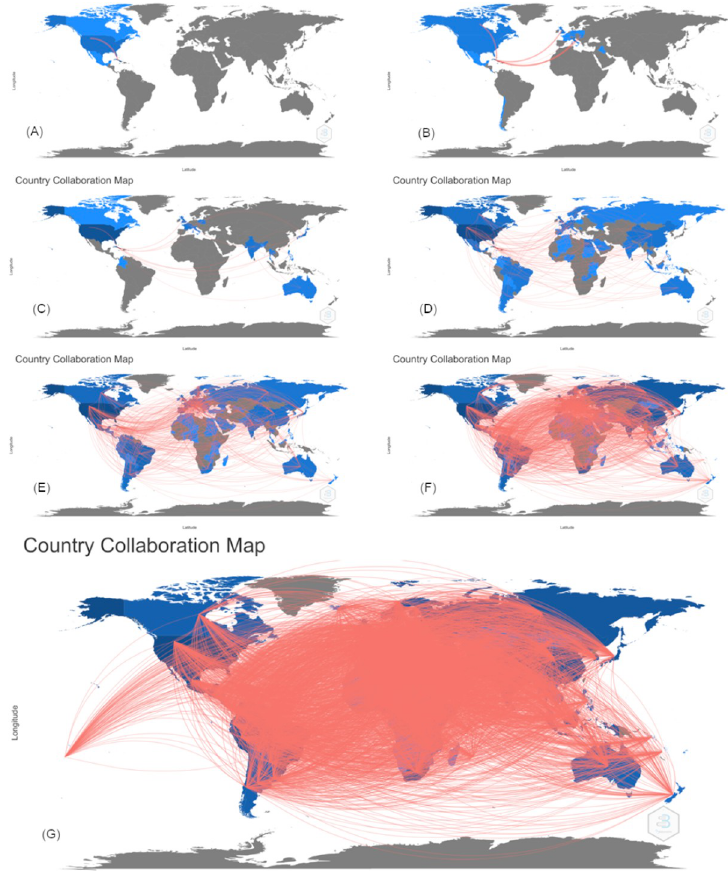
Fig 3. The evolution of the Cuban scientific international collaboration network 1900–2020. (A). The Cuban collaboration network 1900–1059. (B). The Cuban collaboration network 1960–1980. (C). Cuban collaboration network after the Smithsonian agreement with the Cuban Academy of Sciences. (D). Cuban collaboration network after the New York Botanical Garden agreement with the Cuban Academy of Sciences. (E). Cuban collaboration network after Bill Clinton’s p2p approach in 1999. (F). Cuban collaboration network after the visit of U.S. science leaders of the AAAS in 2009. (G). Cuban collaboration network after the Obama approach in 2015. The country collaboration maps were prepared using the R program bibliometrix, an open-source tool for quantitative research in Scientometrics. Available at: https://www.bibliometrix.org.